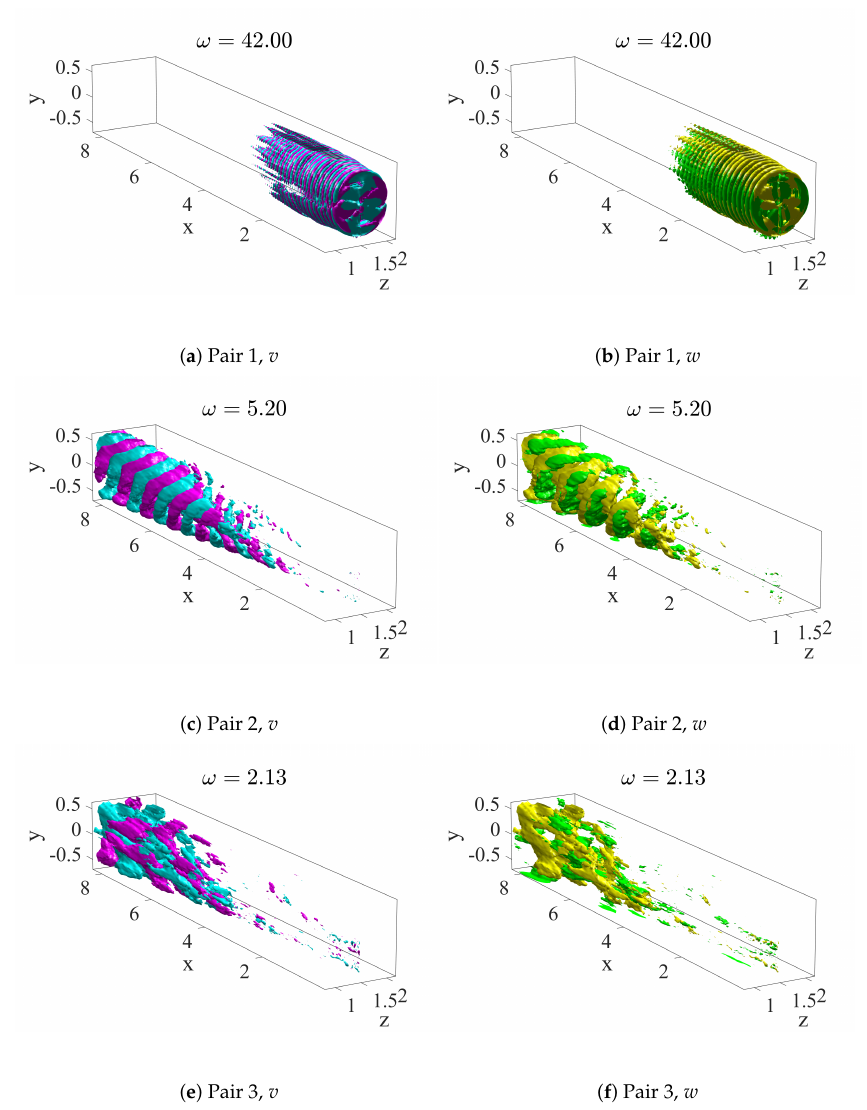
Figure 10. Vertical ( left ) and transverse ( right ) velocity iso-surfaces (magenta/green for v , w = 0.0008, cyan/yellow for v , w = − 0.0008 values) of the real part of the most relevant three dynamic modes’ pairs selected by the sparsity-promoting algorithm, ordered according to their amplitude | α |